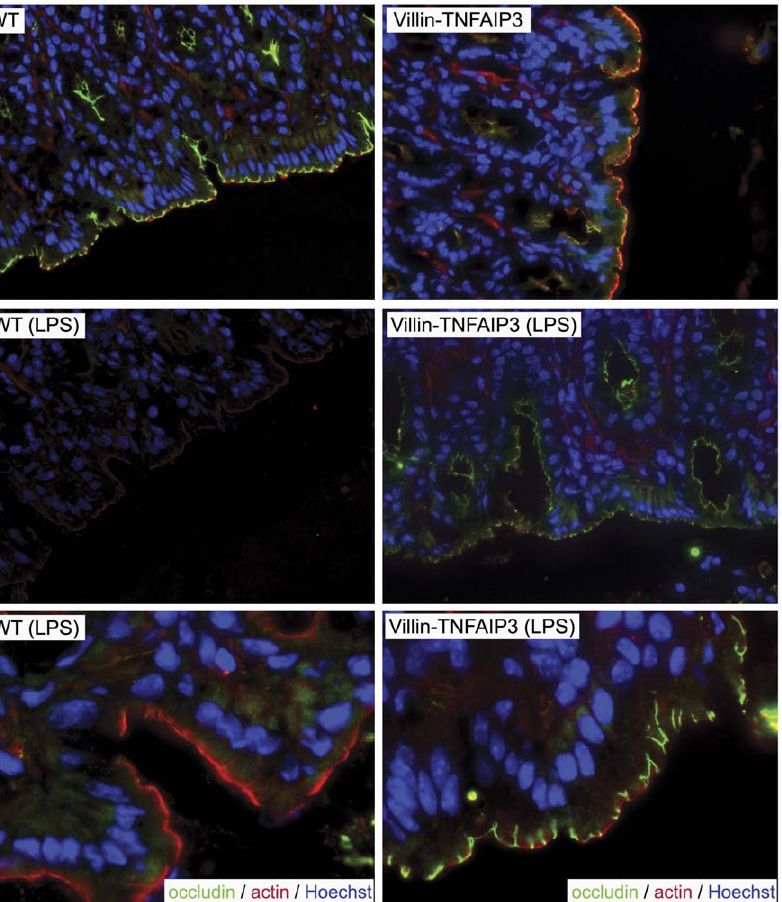
Figure 4. Intestinal epithelial cell-specific expression of TNFAIP3 protects against LPS-induced disruption of tight junctions. Immunohistochemistry showing occludin (green), actin (red) and DNA (blue) localization in the intestinal epithelium of untreated (upper two panels) or LPS-treated (lower four panels; 0.1 mg/mouse, , 5 mg/kg i.p.) mice is displayed. (Upper four panels 40X objective lens; lower two panels 100X objective